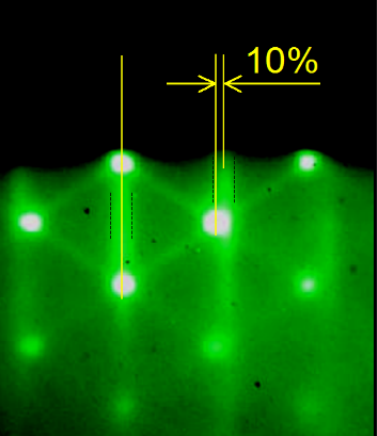
Figure 3. RHEED pattern obtained after the SAQDs formation in HS D . The dotted black lines mark the 2D reflections associated with the diffraction on the AlP surface superstructure.